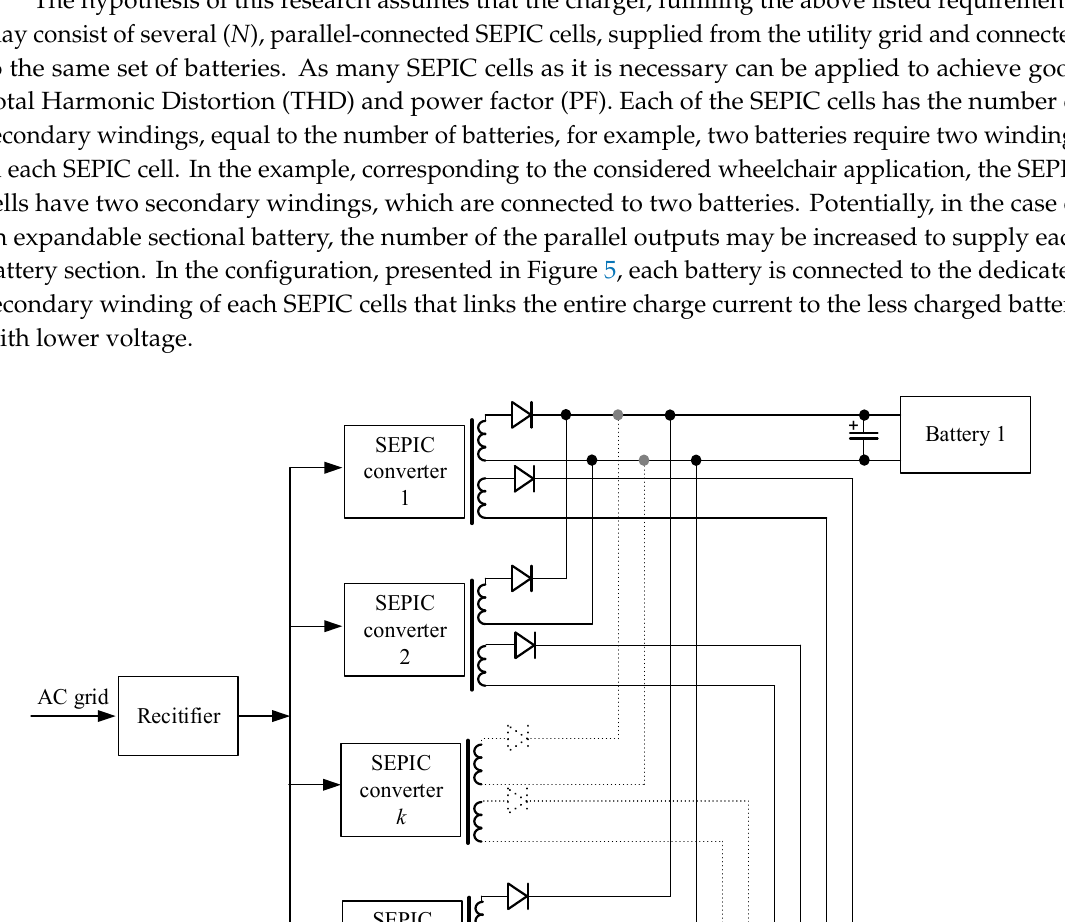
Figure 5. Simplified configuration of the proposed charger.